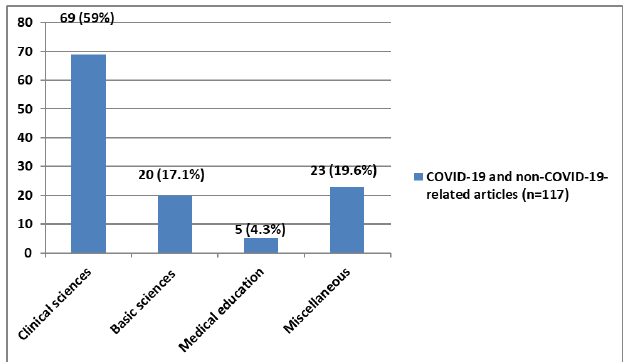
Figure 1: The covered areas of articles published in KCMJ between